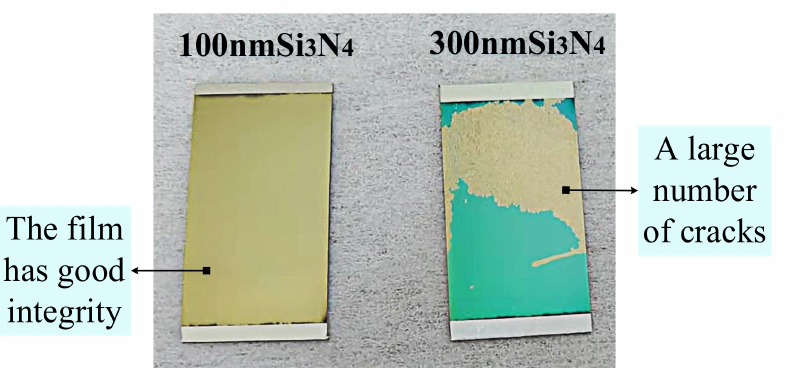
Figure 12. Si 3 N 4 films with different thicknesses deposited on TiN films with the same thickness: 100 nm ( left ), 300 nm ( right